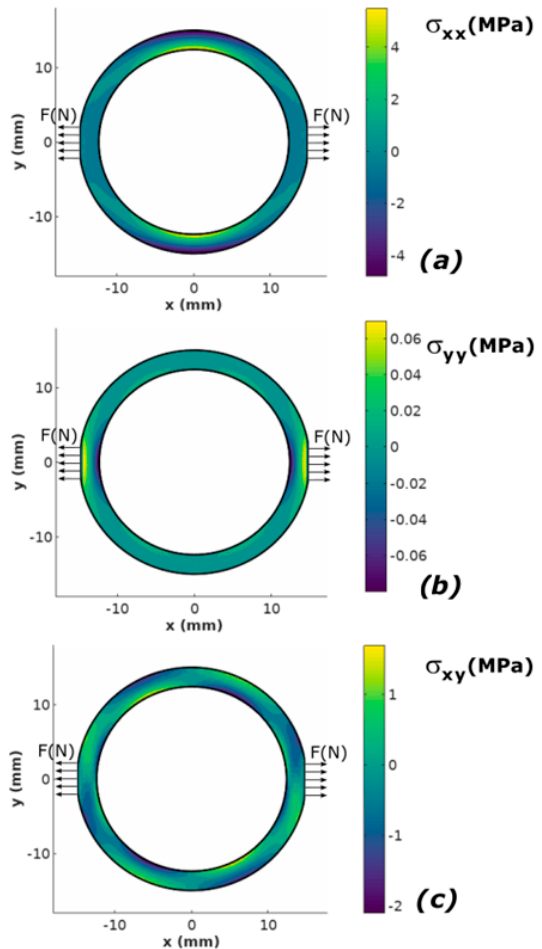
Figure 3. The mechanical stress distribution in the ring-shaped core of the magnetoelastic sensor in Mohri’s configuration, loaded by the measured tensile force F: ( a ) an axial stress σ xx , ( b ) an axial stress σ yy , ( c ) the shear stress σ xy.